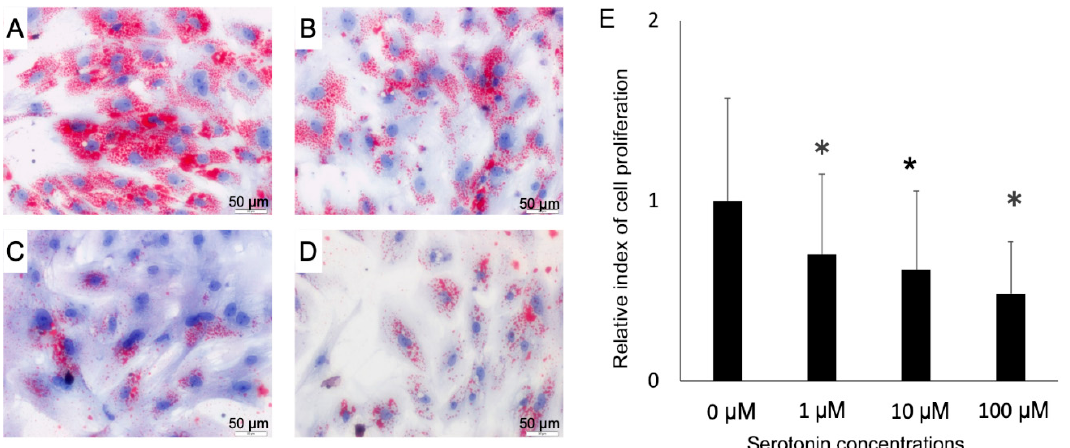
Figure 4. The Oil red O staining image is showing the serotonin-induced fat accumulation in- ( A – D ), and the rate of death / proliferation of adipocytes ( E ). Di ff erentiated adipocytes were stimulated with 0 (control), 1, 10 or 100 µ M and then fat accumulation was measured at four days post-stimulation by thin layer chromatography. A , control; B , 1 µ M; C , 10 µ M and D , 100 µ M. Lipid droplets stained red color and cellular nuclei stained blue color (A–D). Results obtained from three independent trials are presented as mean ± standard deviation. * < 0.05, significant di ff erence against the unstimulated control